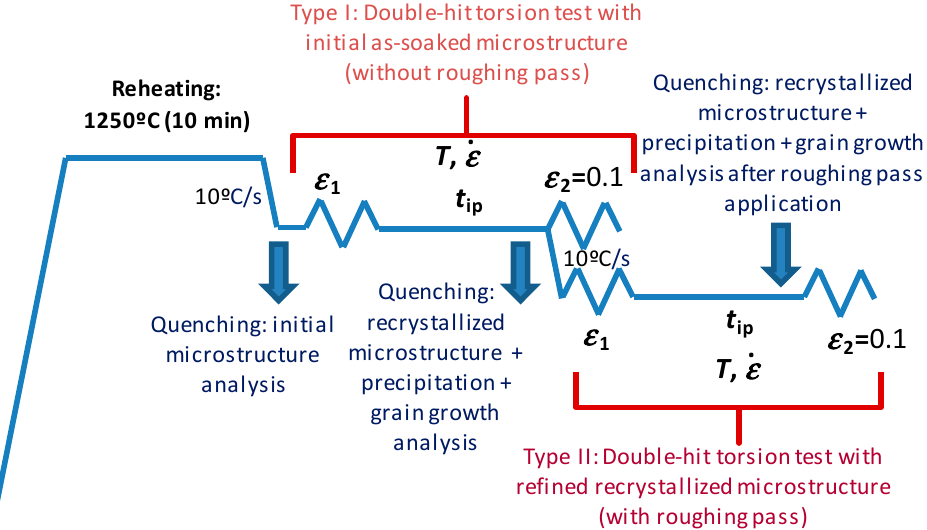
Figure 1. Thermomechanical cycles employed in the double-hit torsion tests and quenching treatments performed for microstructural analysis .